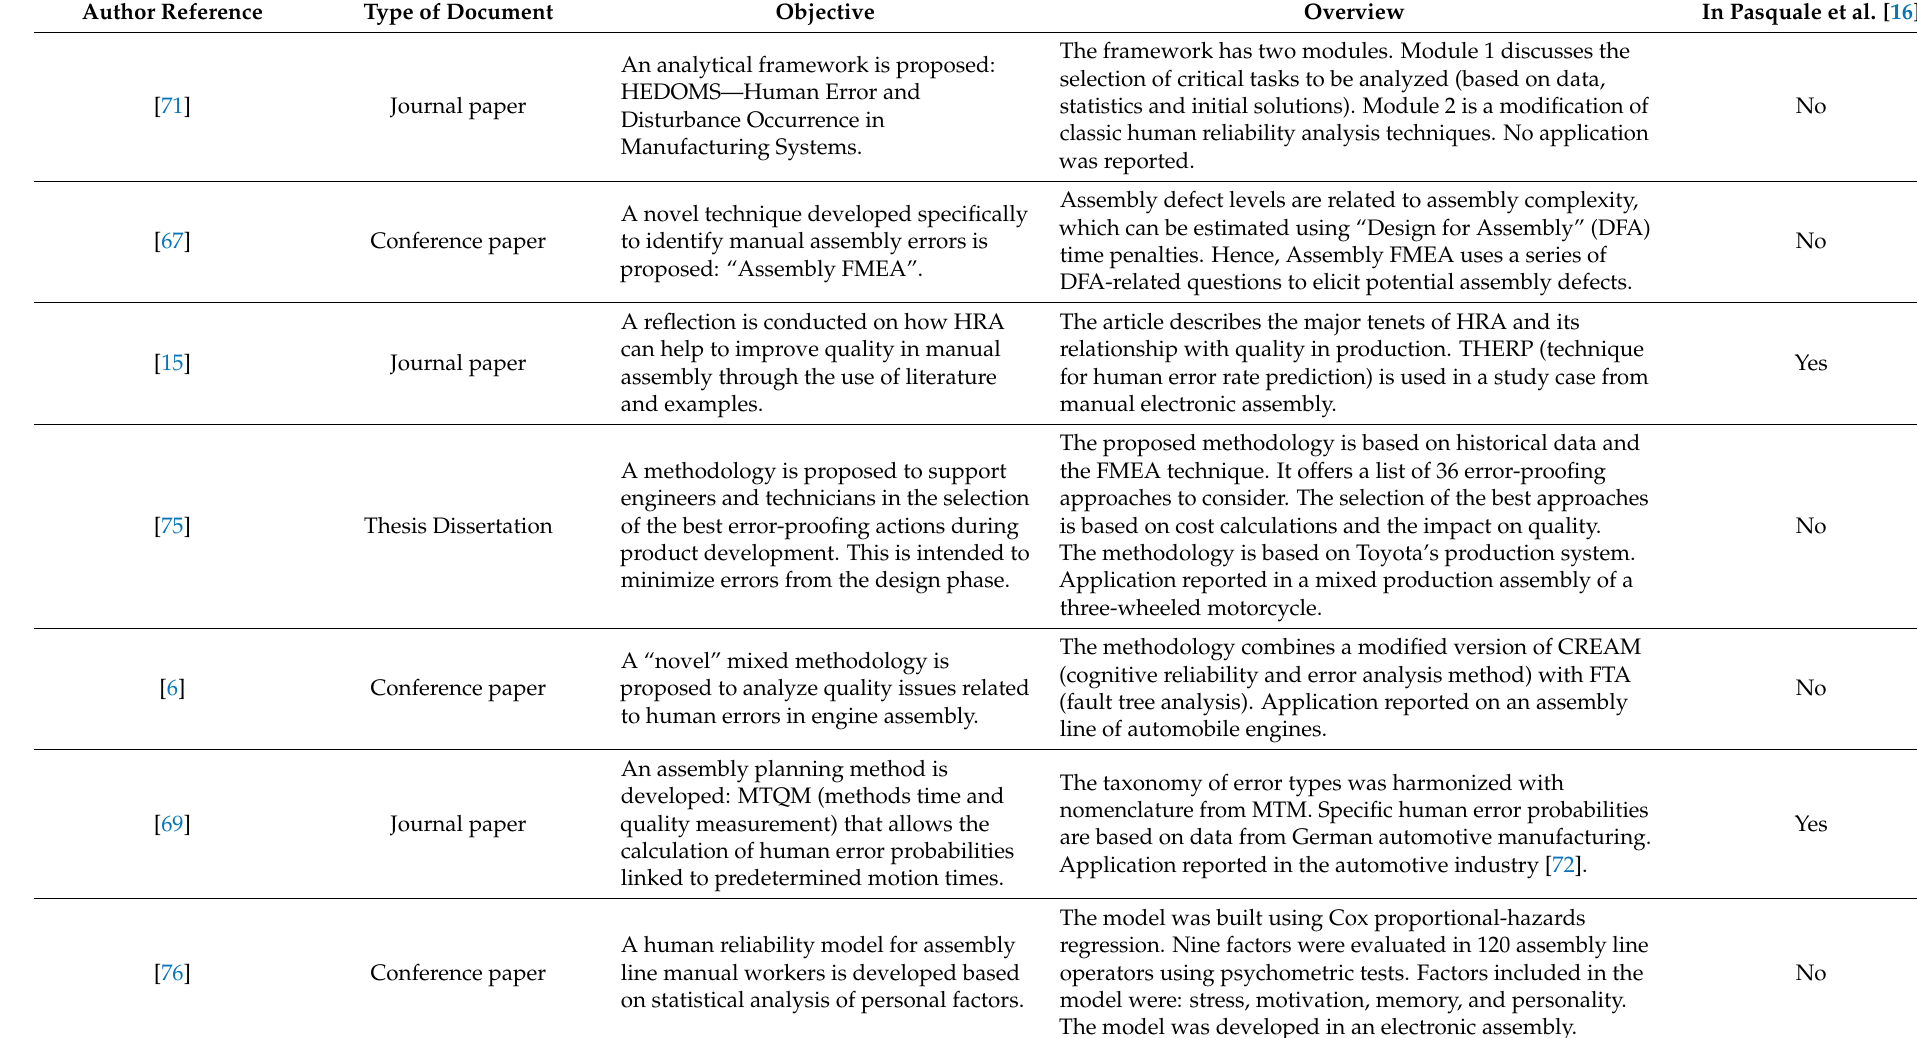
Table 1. Some developments and applications of human reliability analysis (HRA) to manual assembly in